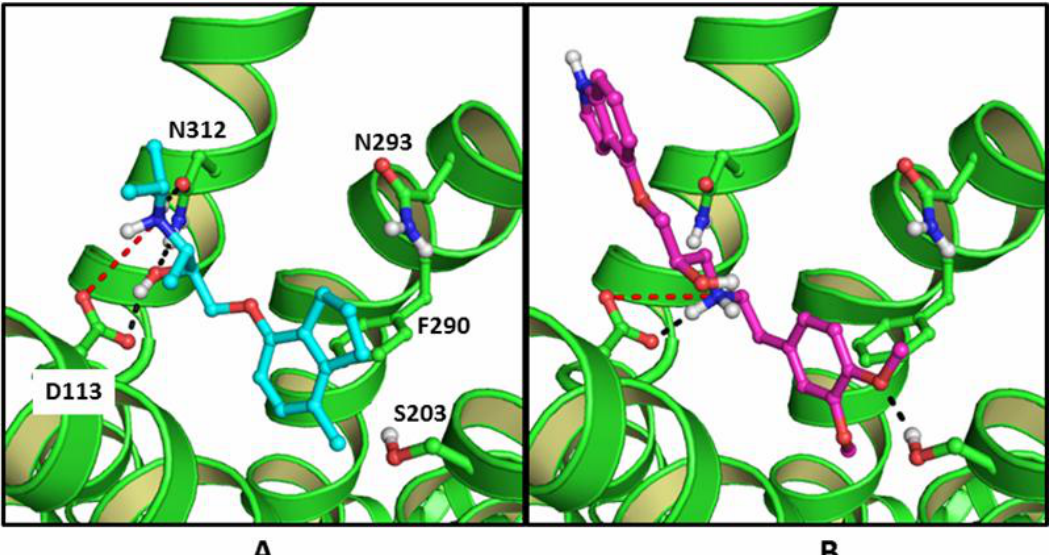
Figure 2. The co-crystal ligands ICI 118.551 (cyan carbon atoms; balls and sticks mode) pose in the ADRB2 binding pocket (Wacker et al. , 2010) (A) and the docking pose of the representative ligand CHEMBL38205 (magenta carbon atoms; balls and sticks mode; Ki at ADRB2 = 3-7nM (Tejani- Butt and Brunswick, 1986; Mysinger et al. , 2012); ChemPLP score = -101.916) in the ADRB2 binding pocket resulted in the SBVS with filtering on poses that have an ionic interaction to D113 (see Table II) with the residue as the anion (B) . The ADRB2 (green carbon atoms) is presented in the cartoon mode with only some important residues are presented in the balls and sticks mode. Oxygen, nitrogen and hydrogen are presented in red, blue and white, respectively. For clarity, only polar hydrogen and interacting residues to the crystal ligand are shown as balls and sticks, while ADRB2 residues from sequence 161 to sequence 200 are not shown. H-bonds and ionic bond are depicted by black dashed lines and red dashed lines,